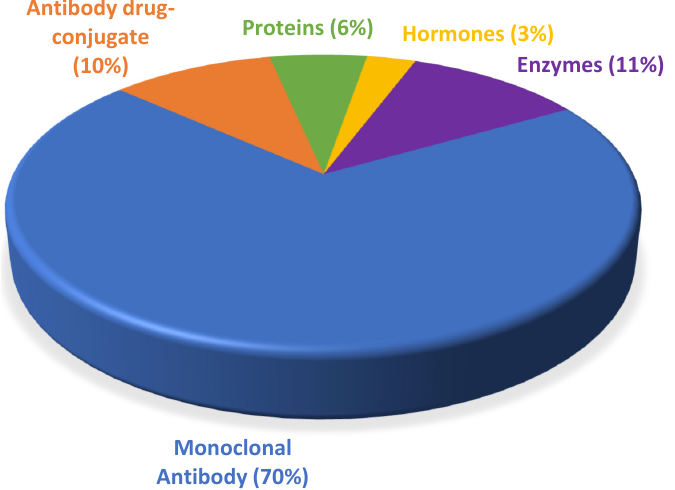
Figure 3. Percentage of new biopharmaceuticals approved by the Food and Drug Administration (U.S. FDA) from 2015 to 2021 [2,17–21].